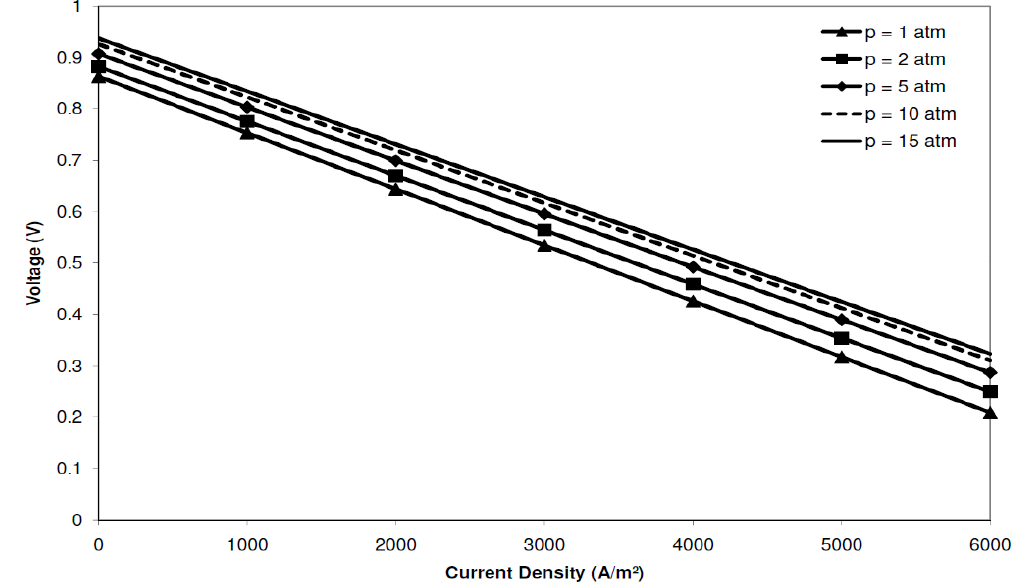
Figure 4. SOFC polarization curve as a function of pressure (methane, 1273 K).